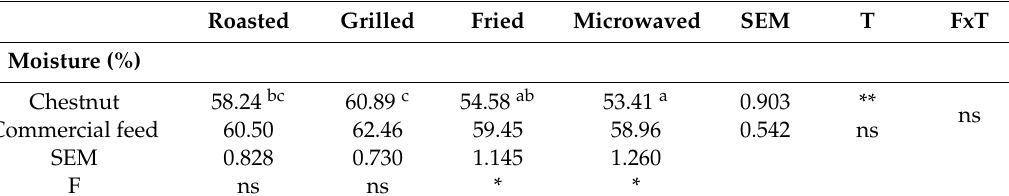
Table 1. E ff ects of the inclusion of chestnut in the finishing diet and of cooking methods on chemical composition of Celta pig Biceps femoris muscle. Roasted Grilled Fried Microwaved SEM